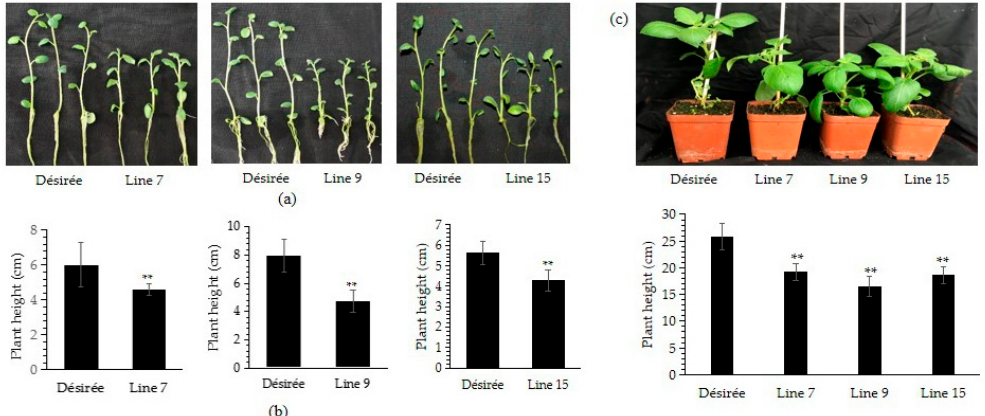
Figure 4. Stable expression of PITG_15718.2 inhibits the vegetative growth of S. tuberosum . ( a ) Images of transgenic lines and controls. Each transgenic line was planted in one tissue-cultural container with Désirée. Three seedlings on each side, forming a confrontation. Images were photographed two weeks after planting; ( b ) the plant height was significantly dwarfed for each transgenic potato line compared to Désirée. The plant height was measured in at least 30 plantlets. ** indicates extremely significant differences determined using the Student’s t -test ( p < 0.01); ( c ) the transgenic lines show stunted phenotype after planting in soil. Image was photographed three weeks after planting into soil. The plant height was measured in at least 20 plantlets. ** indicates extremely significant differences determined using the Student’s t -test ( p < 0.01).